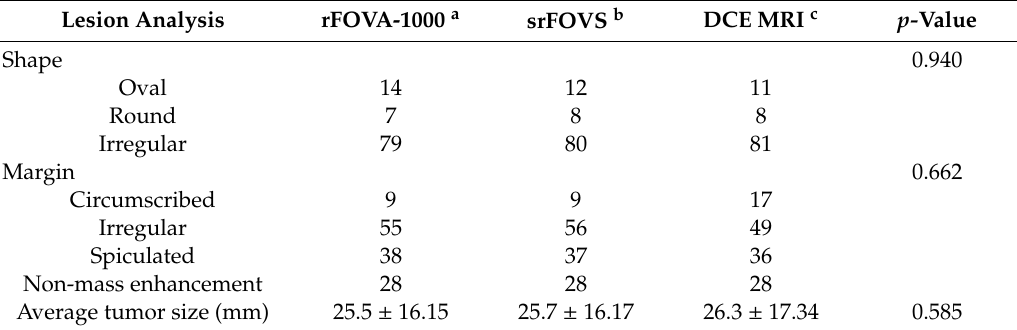
Table 3. Comparisons of morphological analysis and size measurement of index cancer among rFOVA-1000, srFOVS, and DCE MRI.